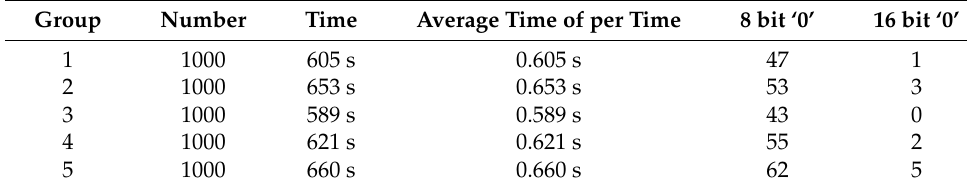
Table 1. Node addresses generate five sets of experimental results.